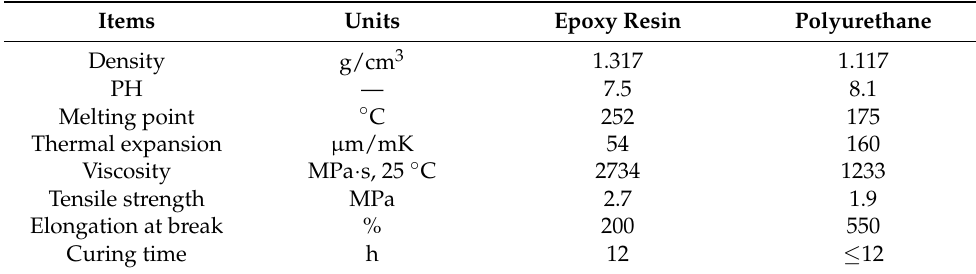
Table 2. Physical and chemical properties of polymer